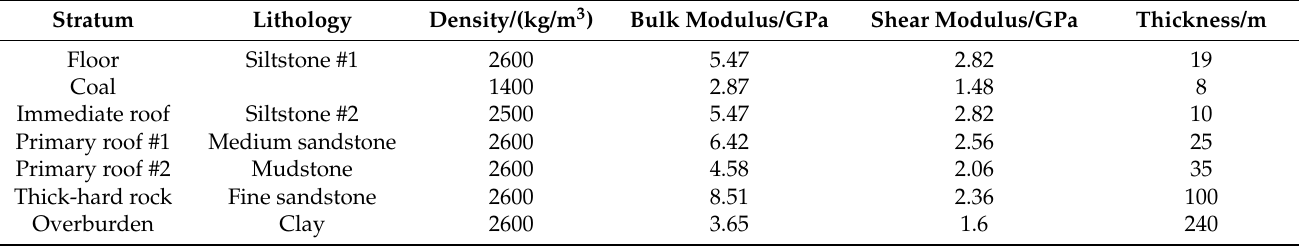
Table 1. Micro-parameters of the